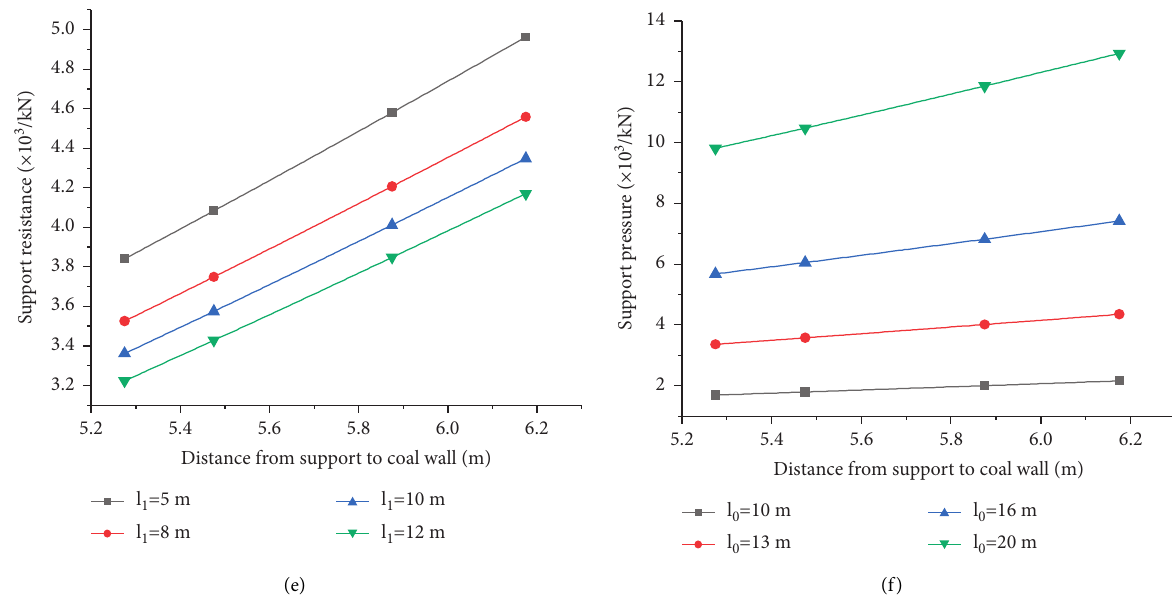
Figure 3: The change curve of the influence of different factors on the working resistance of the stent. (a) Different stress concentration factors k . (b) Different buried depths H . (c) Different elastic moduli E . (d) Different top plate thicknesses h . (e) The distance between the peak of different supporting pressure and the coal wall l 1 . (f) The length of different roof cantilever l 0